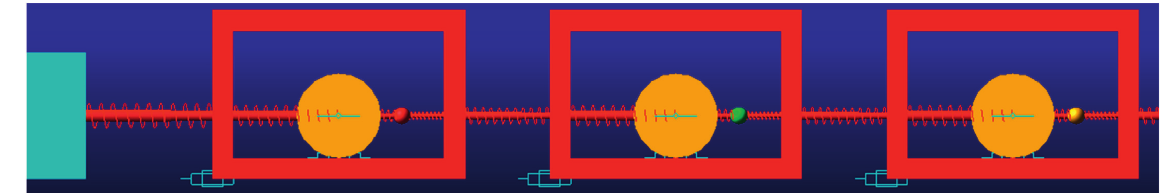
Figure 8: A schematic of the EMM arrangement of 2DOF model-MSC-ADAMS software.